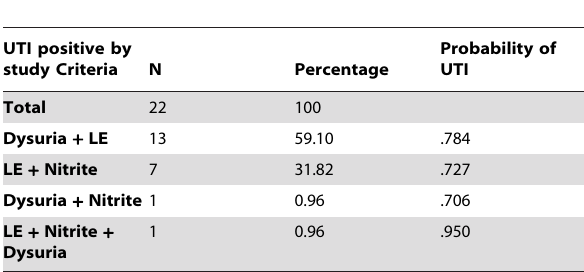
Table 2. Data from analysis of UA results, Veraguas, Panama, April 2010.